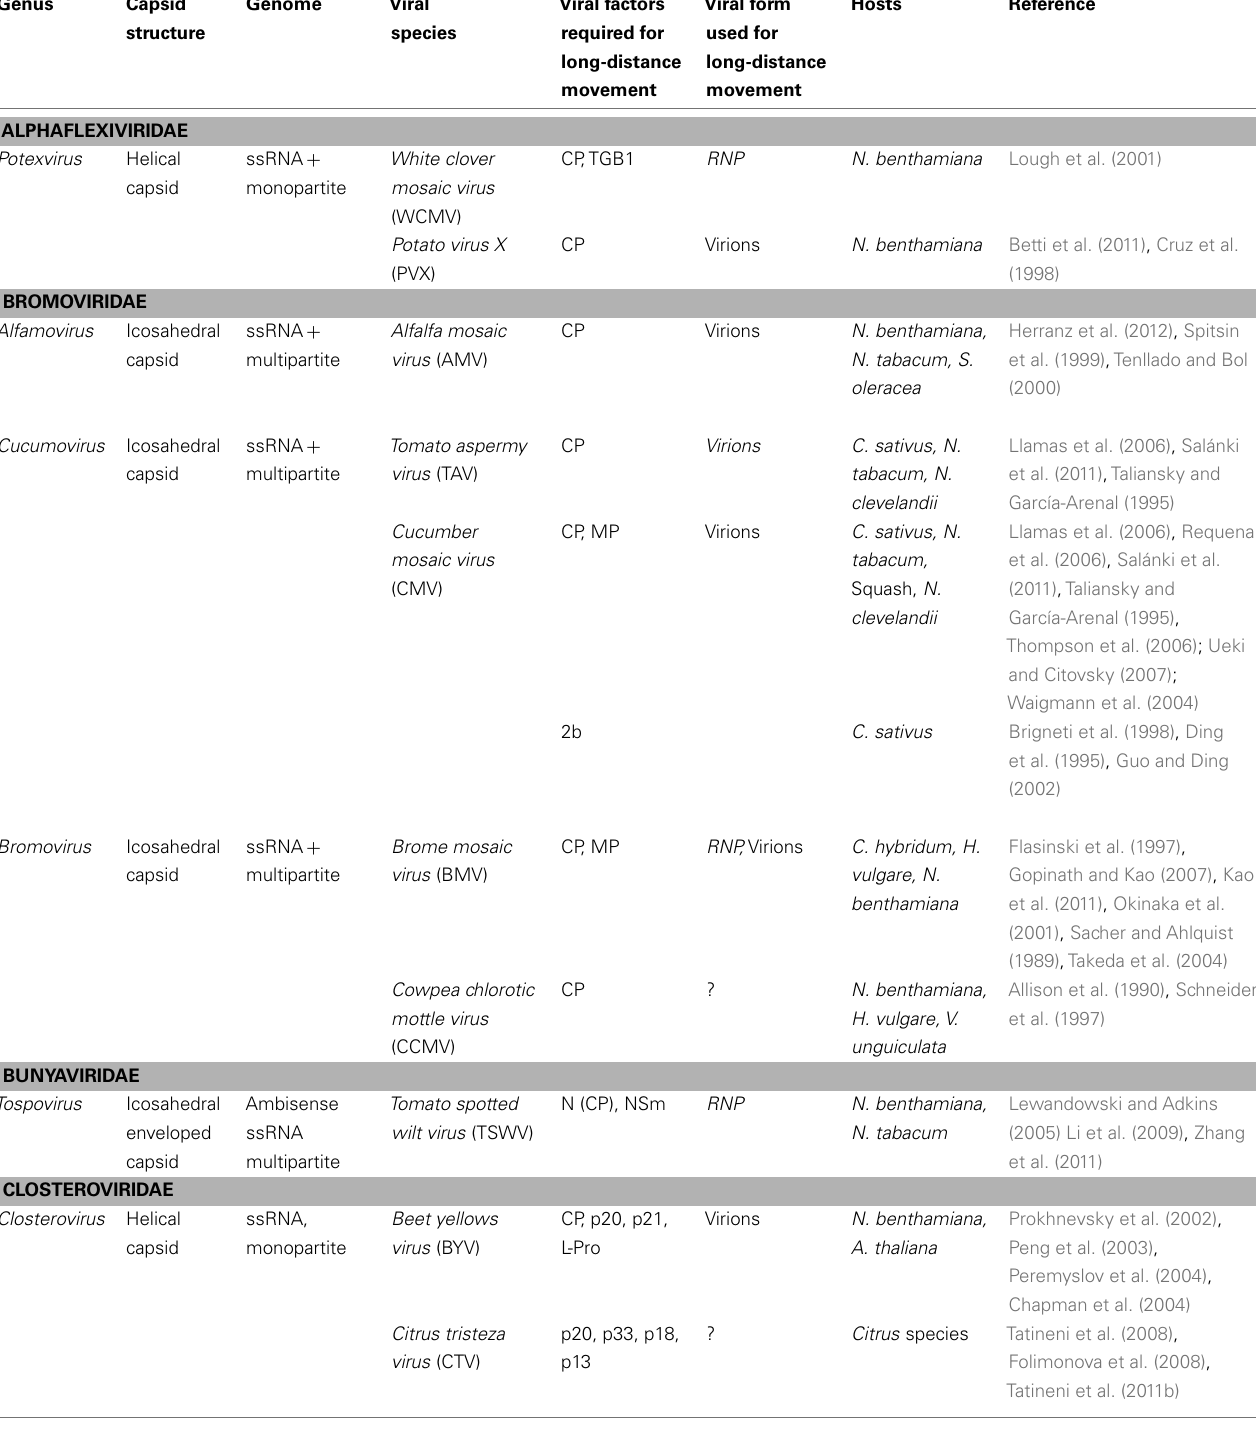
TableA1 |Viral proteins and transport complexes involved in virus long-distance movement.